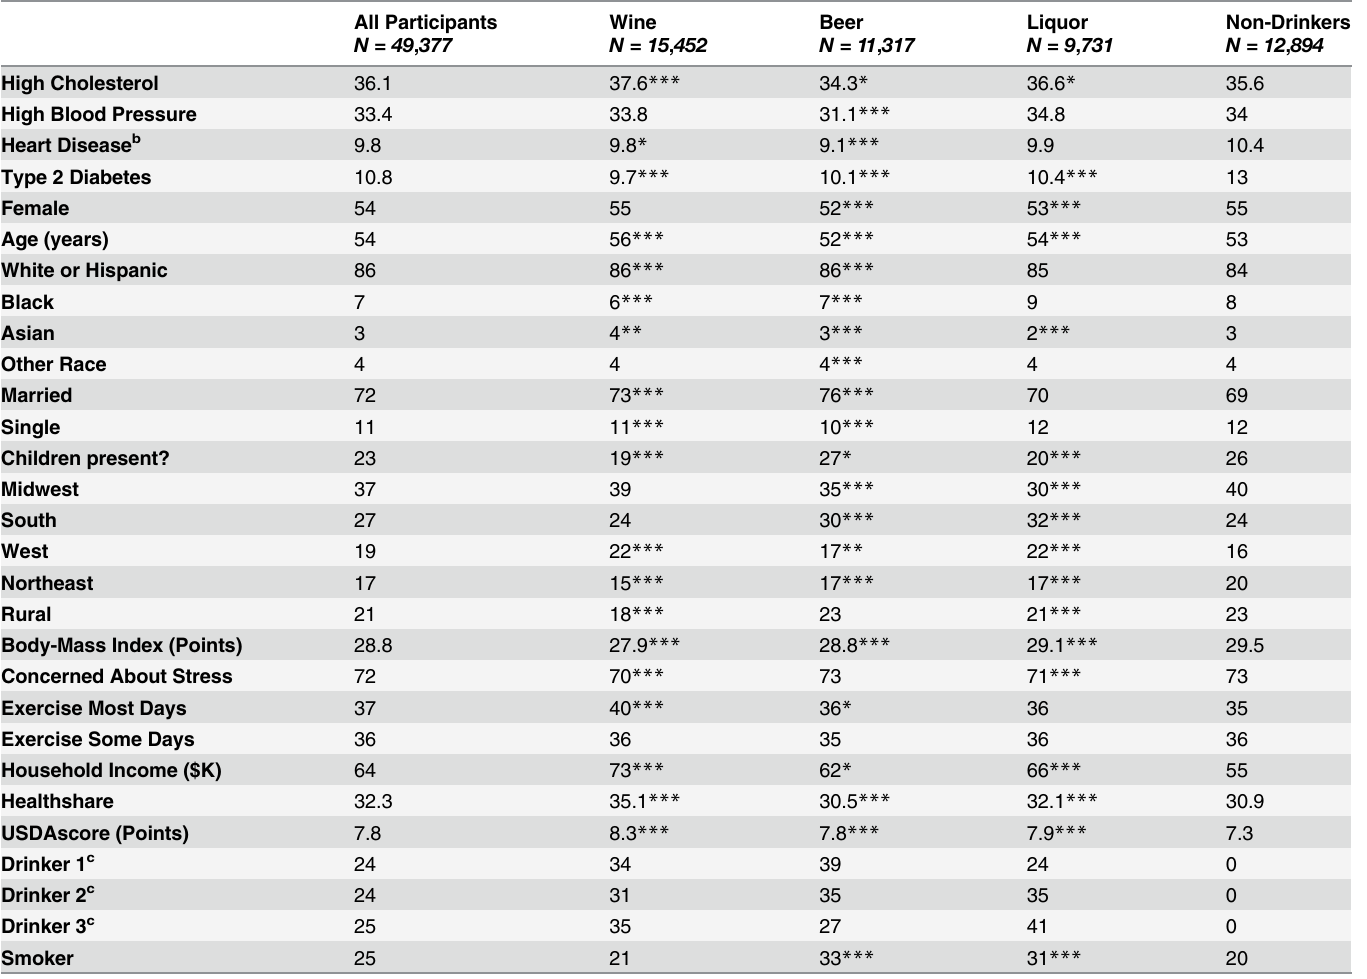
Table 1. Variable Means for the 2010 MedProfiler Survey Population Households, Stratified by Alcohol Type Preference a . All